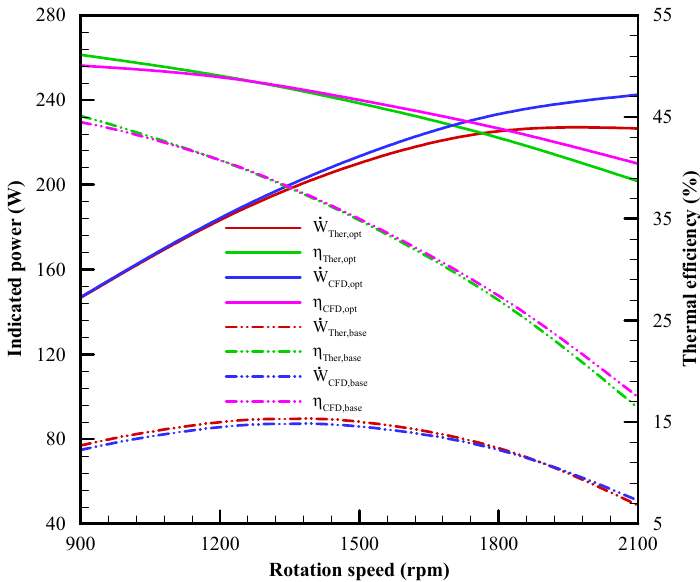
Figure 8 points out the effect of the rotation speed on the optimal engine performance over the range from 900 to 2100 rpm. Before optimization, the CFD model and the modi- fied thermodynamic model in the VSCGM optimizer show a good agreement. Their re- spective maximum differences in the indicated power and the thermal efficiency are 2.4 W at 1350 rpm and 1.1% at 2100 rpm. After optimization, the raise in rotation speed over this range leads to an improvement in both the optimal indicated power and the optimal thermal efficiency. The optimal thermal efficiency goes down from 51.1 to 38.7% and the optimal indicated power rises from 146.7 to 226.6 W as the rotation speed increases from 900 to 2100 rpm. The comparison between the CFD model and the VSCGM optimizer in- dicates that the respective maximum differences in the optimal thermal efficiency and the optimal indicated power are 1.7% and 15.9 W at 2100 rpm. Figure 7. Variation of the optimal engine performance with the charged pressure.